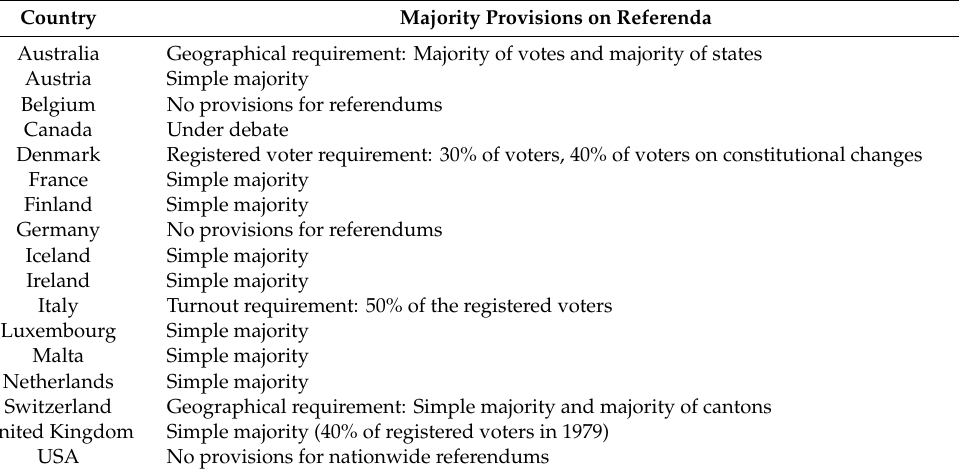
Table 1. Majority provisions on referenda in established Western democracies *.